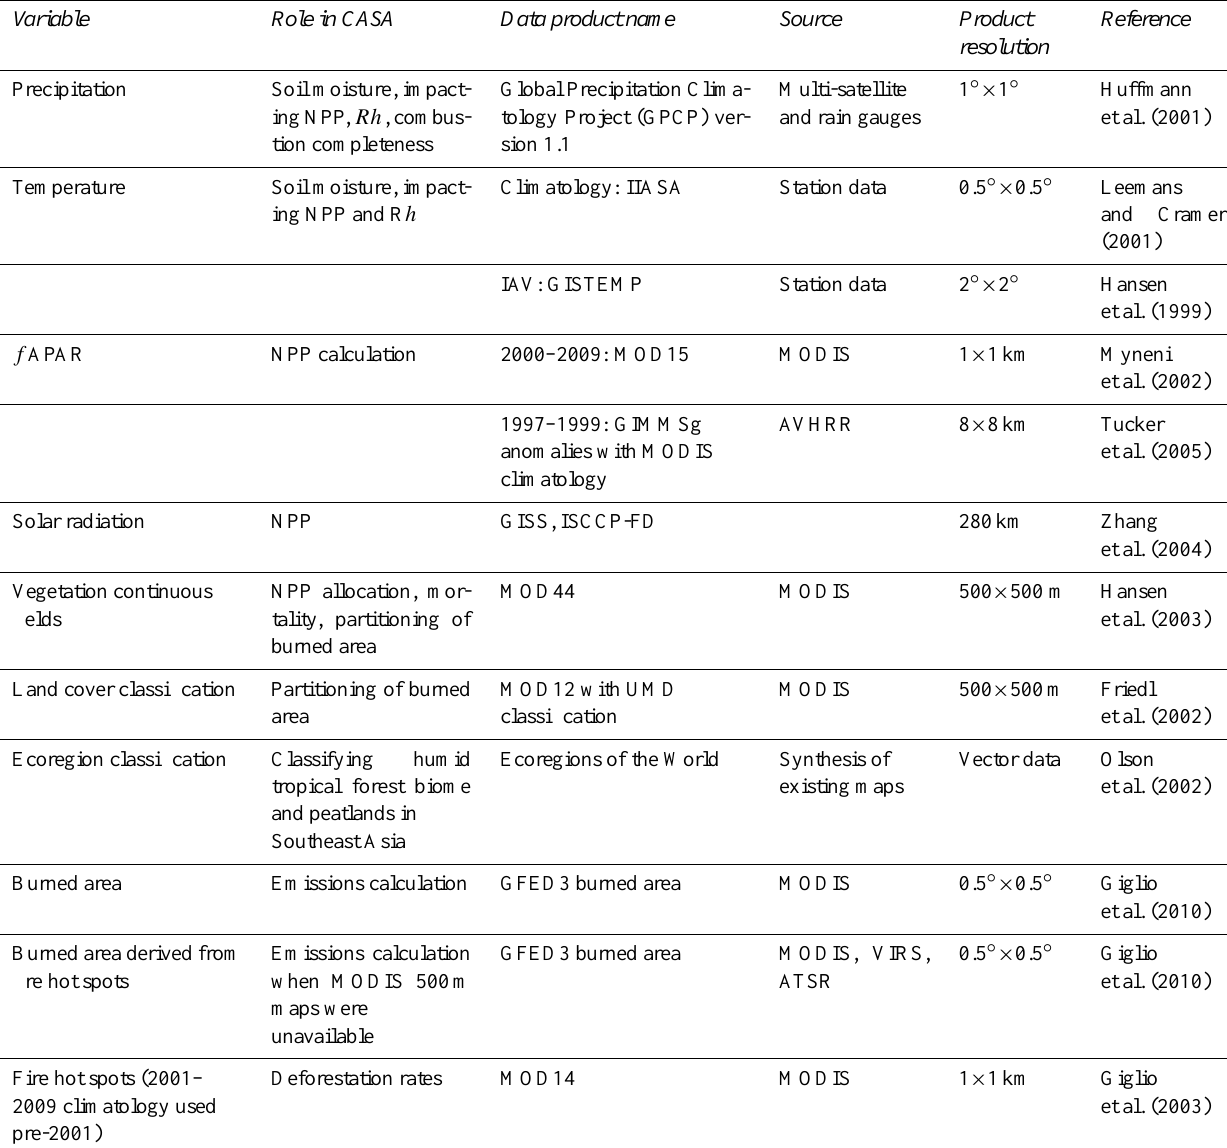
Table 2. Data sets used to drive the CASA-GFED modeling